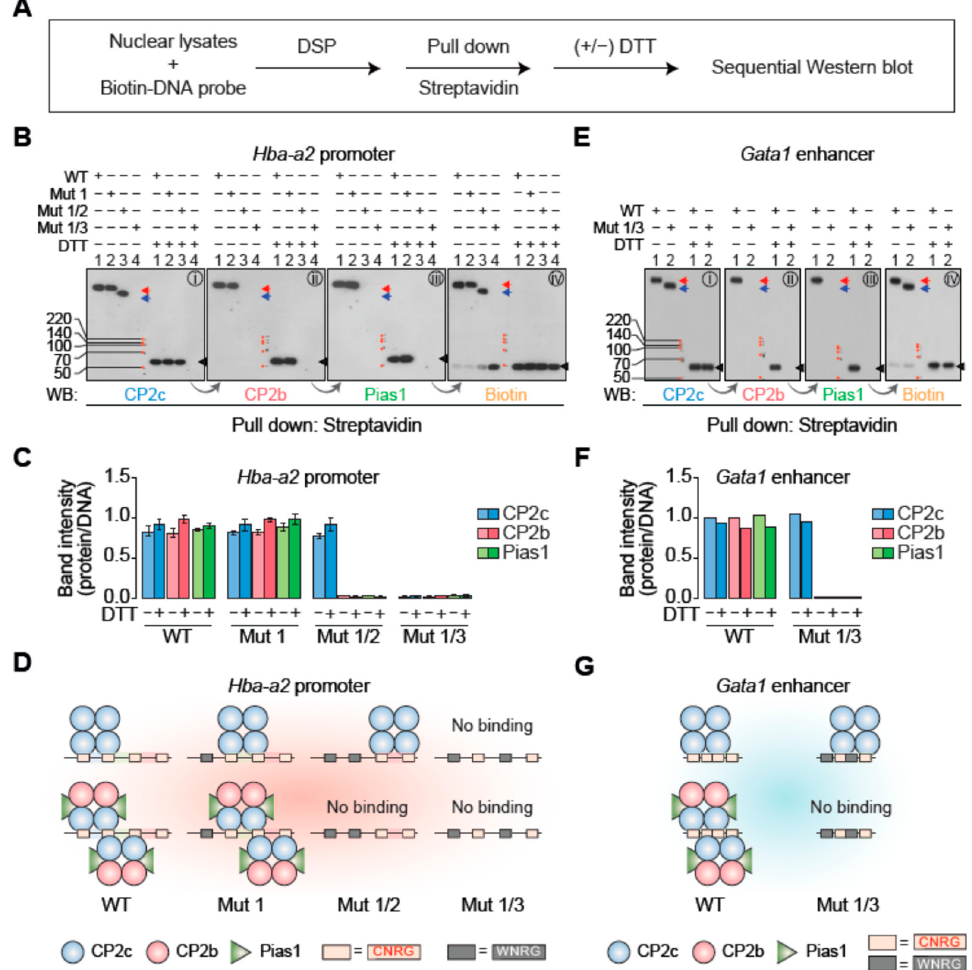
Figure 3. Stable DNA binding occurs either by monomeric tCP2c ([C4]) or dimeric CBP ([C2B2P2] 2 ). ( A ) Experimental scheme for the determination of identity and stoichiometry of CP2c complex proteins by DSP crosslinking and sequential Western blot. ( B – D ) Identity and stoichiometry of CP2c complex proteins bound to the wild type or various CP2c binding motif mutations in the Hba-a2 promoter (see Figure 2B). Immunoblots ( B ) and the quantification of each spot ( C ) show that the same relative amounts of CP2c, CP2b, and Pias1 exist in the CBP complex, while both tCP2c and CBP complexes contain the same amounts of CP2c. Samples were subjected to 10% SDS-PAGE. N = 2. ( D ) Schematic models showing stoichiometry of tCP2c and CBP complexes bound to their wild type or various CP2c binding motif mutants in the Hba-a2 promoter. ( E – G ) Identity and stoichiometry of CP2c complex proteins bound to the wild type or various CP2c binding motif mutations in the Gata1 enhancer (see Figure 2D). Immunoblots ( E ) and the quantification of each spot ( F ) show that the same relative amounts of CP2c, CP2b, and Pias1 exist in the CBP complex, while both tCP2c and CBP complexes contain the same relative amounts of CP2c. Samples were subjected to 10% SDS-PAGE. ( G ) Schematic models showing stoichiometry of tCP2c and CBP complexes bound to their wild type or mutant CP2c binding motif in the Gata1